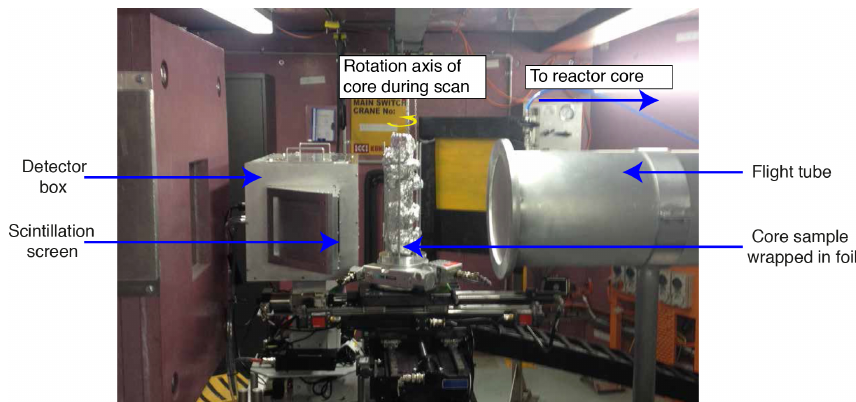
Figure 2. Set-up of DINGO for NT scanning of DFDP-1 core. The field of view is approximately 2.5m